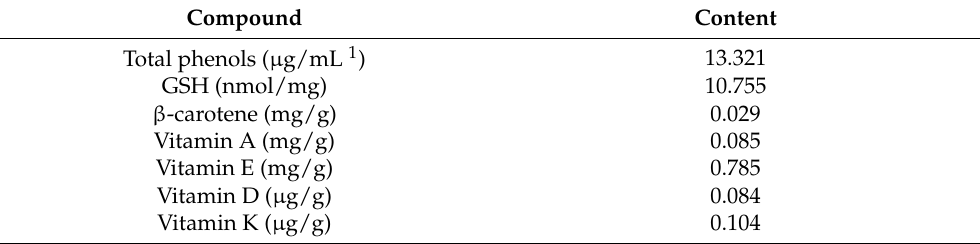
Table 1. Content of selected bioactive compounds in the extract of whole spiny-cheek crayfish.